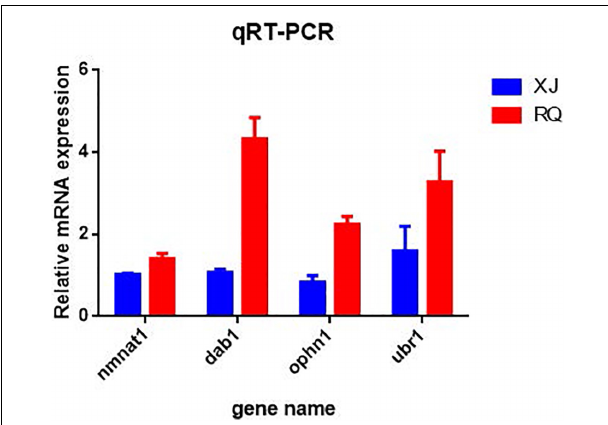
FIGURE 6 | Quantitative real time PCR (qRT-PCR) validation of differentially expressed genes (DEGs) in each surface-cave group. The relative mRNA expression level is presented on the X -axis after normalization to β -actin. Bars in each panel represent the mean ± standard ( n = 3); the red and blue colors in the bars indicate that the relative mRNA expression of Sinocyclocheilus cavefish and surface fish